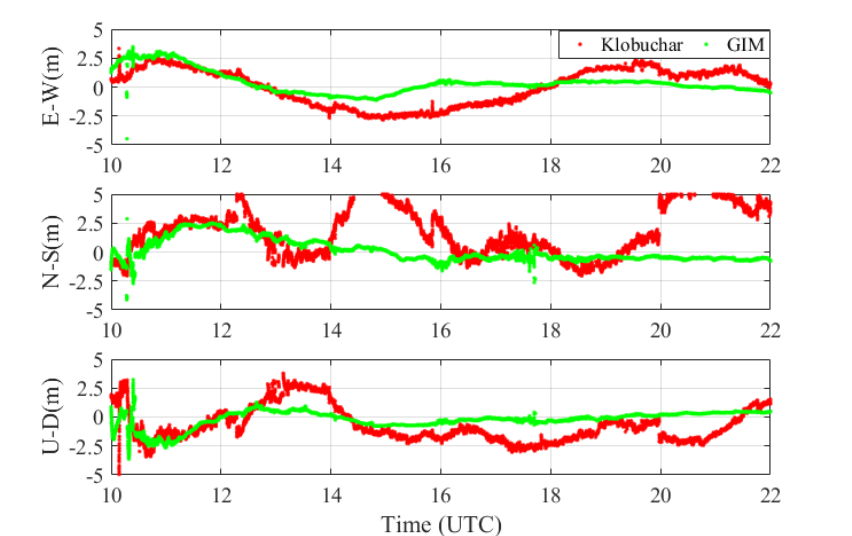
Figure 13. Klobuchar–based and GIM–based SF RT–PPP solutions in the east, north, and up directions from 10:00 to 22:00 on 12 September